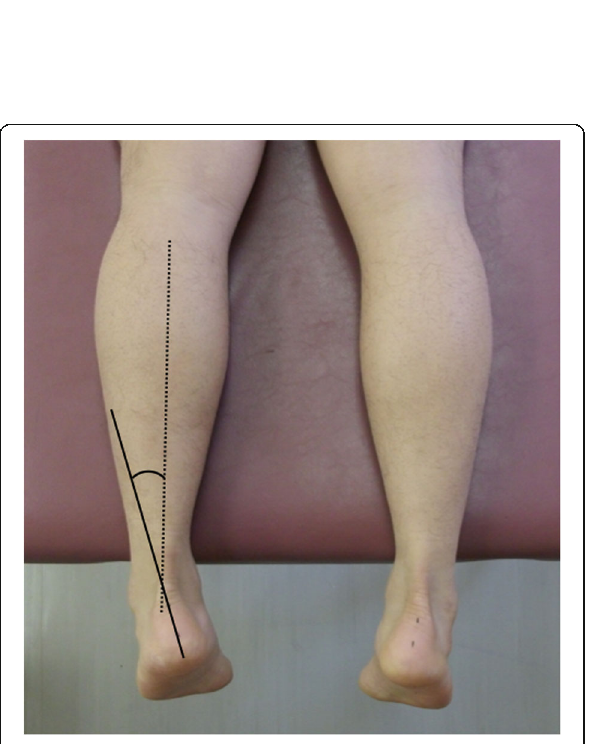
Fig. 2 Measurement of N-LHA. Subjects were placed in the non- weight-bearing position and we measured the angle between the lower leg line and calcaneus line using imageJ